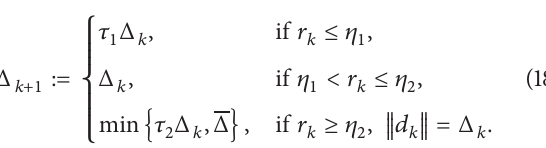
Figure 4: The phase current waveforms in normal state.